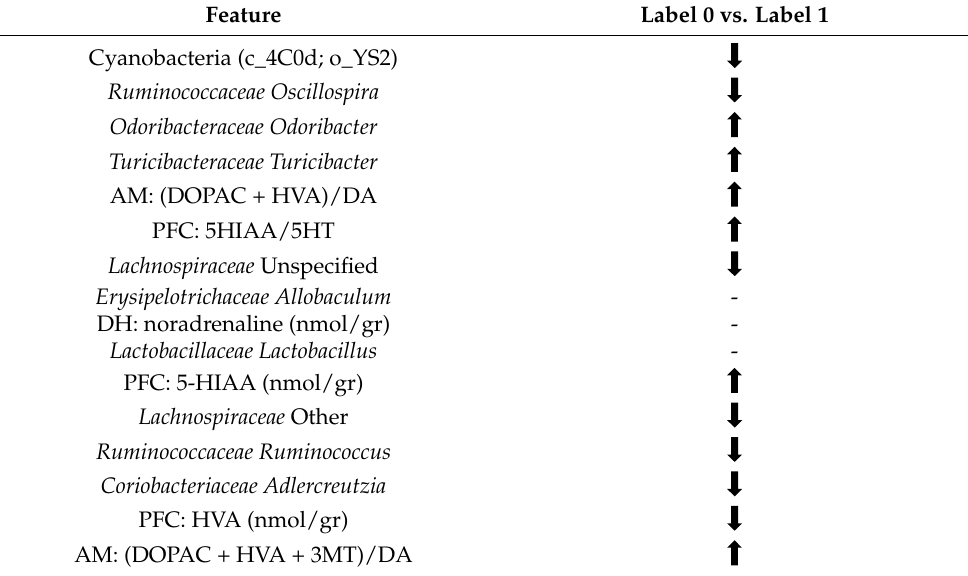
Figure 10. The datasheet of the entire study was analysed regarding marble burying (number of marbles buried) at 8 weeks of age (early adulthood). ( A ) After running the REFS algorithm 10 times, the best signature is at 9 features, with an average global accuracy of all classifiers of 0.73. ( B ) The optimal associated receiver-operating characteristic (ROC) curve for the best-performing classifier Ridge demonstrates an area under the curve (AUC) of 0.84 ± 0.17. ( C ) The 9 features separating the two labels: 0 = Adlercreutzia, 1 = DH: tryptophan (nmol/gr), 2 = Lachnospiraceae Other, 3 = Dehalobacterium, 4 = Th17 cells in MLN, 5 = Activated Th2 cells in spleen, 6 = α -diversity (Shannon index), 7 = PFC: noradrenaline (nmol/gr), 8 = PFC: noradrenaline (nmol/gr), and 9 = Th1 cells in MLN. Label 0: number of buried marbles <10. Label 1: number of buried marbles ≥ 10.